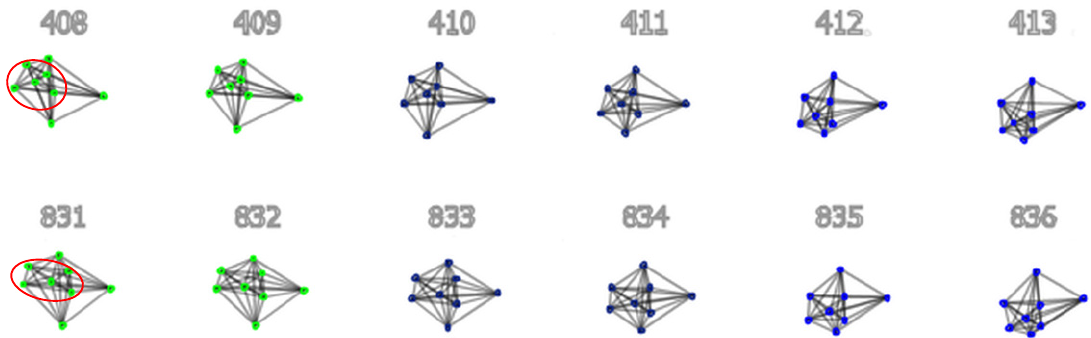
Figure 10. Movement pattern of the whole team which occurs twice during the game.